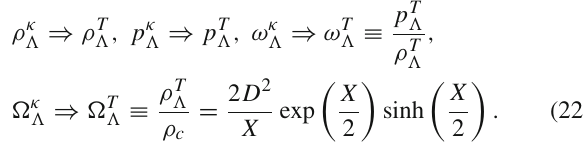
, (19) (cid:7) (cid:8) m > 0 only if ω (cid:7) < − 1 (cid:8) κ (cid:7) = 2. In Fig. 3, a variety of the (cid:8) κ (cid:7)